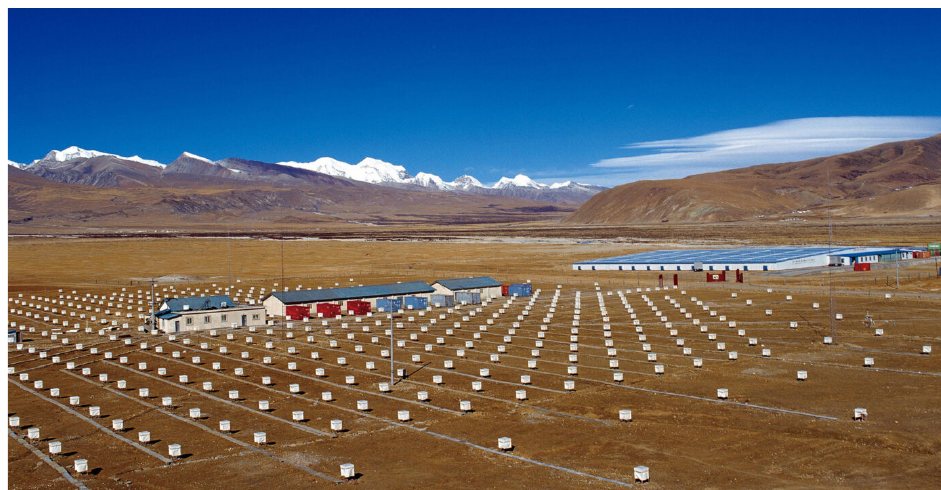
Figure 2. Example of a typical air shower array (Tibet AS γ experiment located at the YangBaJing Cosmic Ray Observatory in Tibet (P.R. China) 4300 m